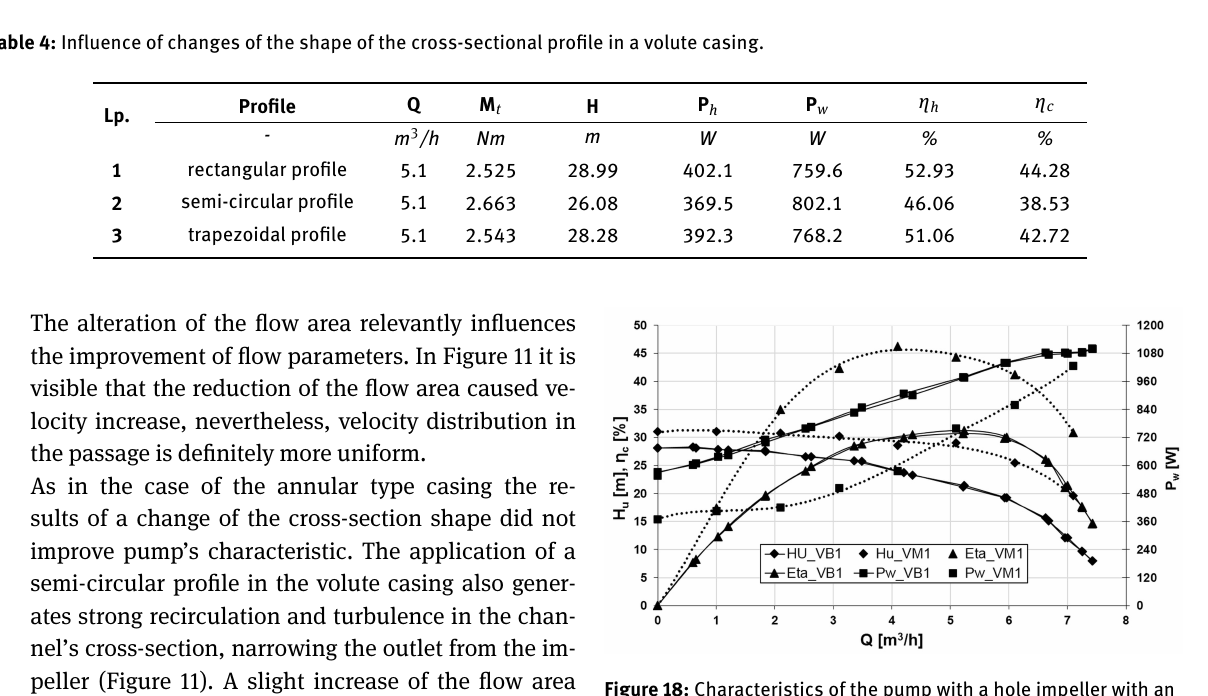
Figure 18: Characteristics of the pump with a hole impeller with an annular casing VB1 and a final volute casing